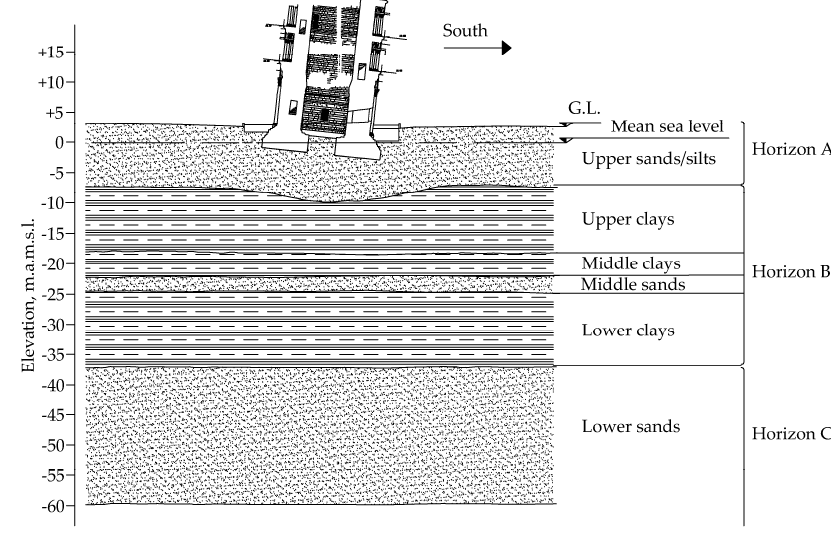
Figure 3. The subsoil of the Tower. (After Viggiani and Pepe, 2005 [11]).